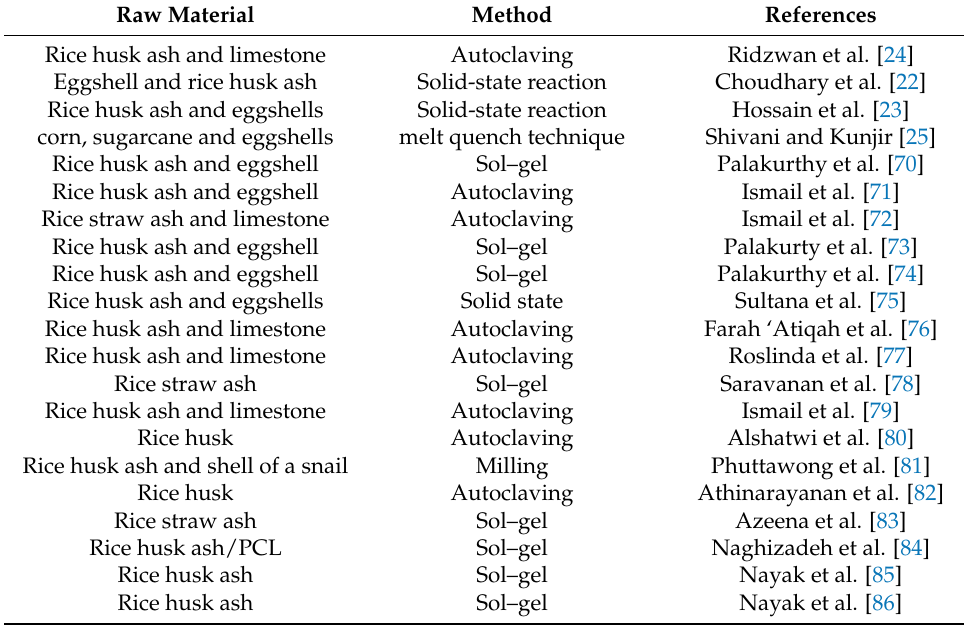
Table 5. Summary of rice husk ash (RHA) and rice straw ash as raw materials, and the methods used to fabricate